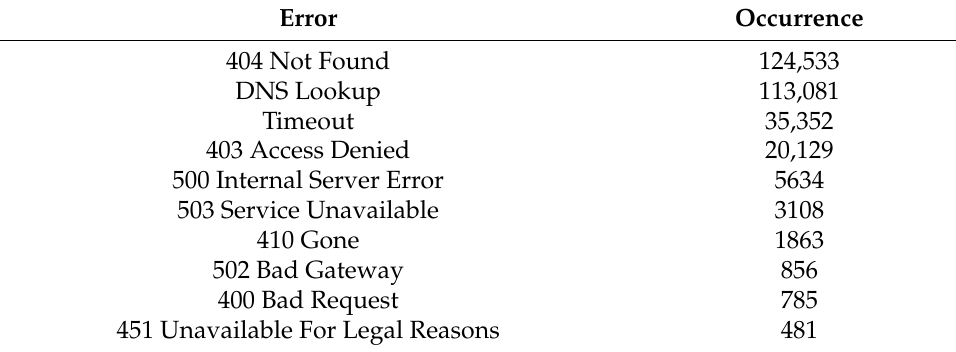
Table 2. The most frequently encountered errors by the